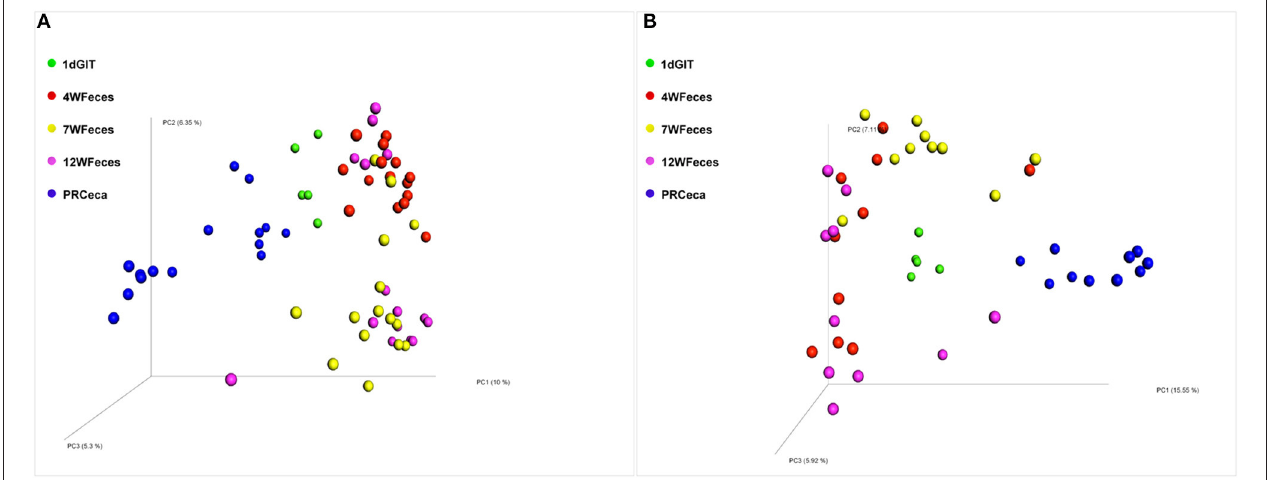
FIGURE 4 | Principal coordinate analysis (PCoA) of beta-diversity of pasture-raised chicken using Unweighted UniFrac distances: 1dGIT, Gastrointestinal contents from 1-day-old broilers; 4WFeces, Feces from 4-week-old broilers; 7WFeces, Feces from 7-week-old broilers; 12WFeces, Feces from 12-week-old broilers; PRCeca,